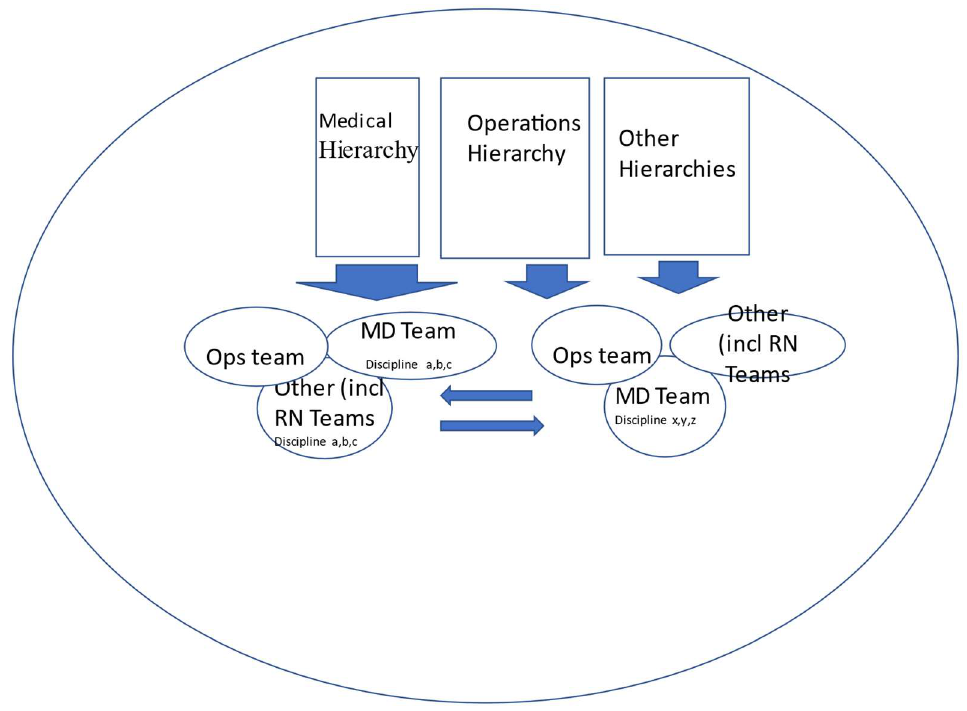
Figure 1. The interactions of a single team within a health care organization. Physicians in the health care teams usually belong to a hierarchical professional structure (medicine, surgery etc.,). Health care organizations are complex entities. Senior leadership needs to define the relationship between the team and the relationship between the teams and their “Departments” or the organizational units in which they operate in order to minimize the conflicts or obstacles for attainment of maximum